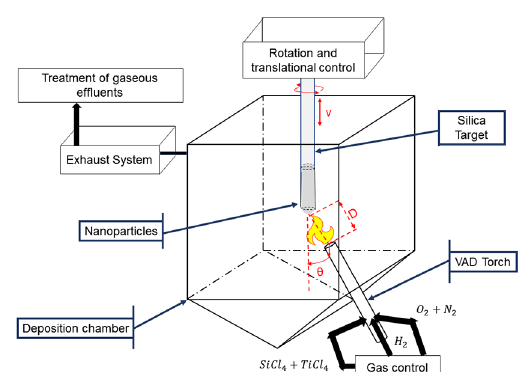
Figure 1. Scheme of the VAD chamber used for the synthesis of soot nanoparticles. A high-temperature O -H flame promotes the hydrolysis 2 2 and oxidation of SiCl , according to reaction 16. The 4 nanoparticles are axially deposited on the surface of a silica rod target in constant rotation and controlled vertical translation movements 19 .